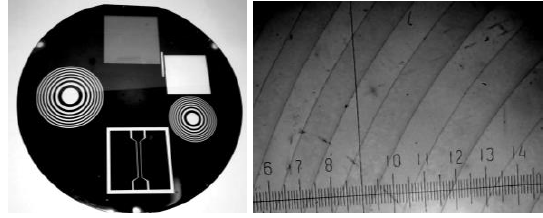
Fig. 4. The different patterns on 3-inch VO 2 film/Al 2 O 3 obtained by photolitographic etching process. The authors thank M.N. Esaulkov, P.M. Soly- ankin and A.P. Shkurinov (Institute on Laser and In- formation Technologies of RAS) for measurements of films THz transmittance. The work was supported by RSF